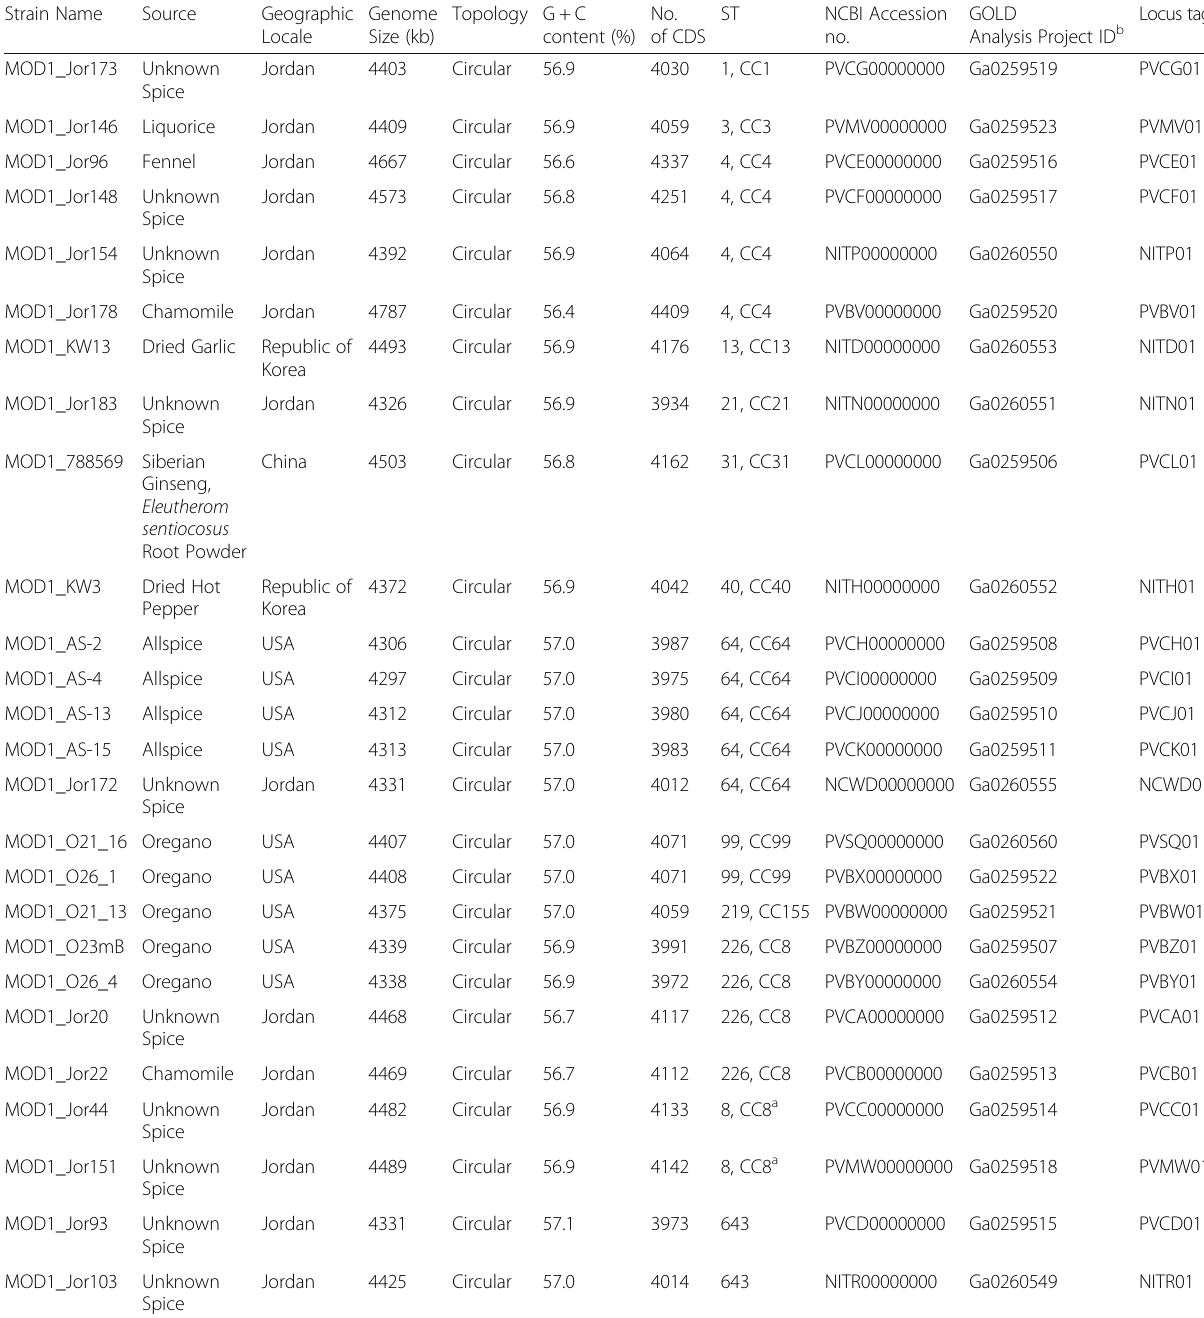
Table 3 Draft genomes, source, geographic locale, genome size, topology, %G + C content, No. of CDS, sequence type (ST), accession numbers, GOLD project ID, and locus tag of strains captured under the FDA-CFSAN Cronobacter GenomeTrakr NCBI BioProject PRJNA258403 and used in this